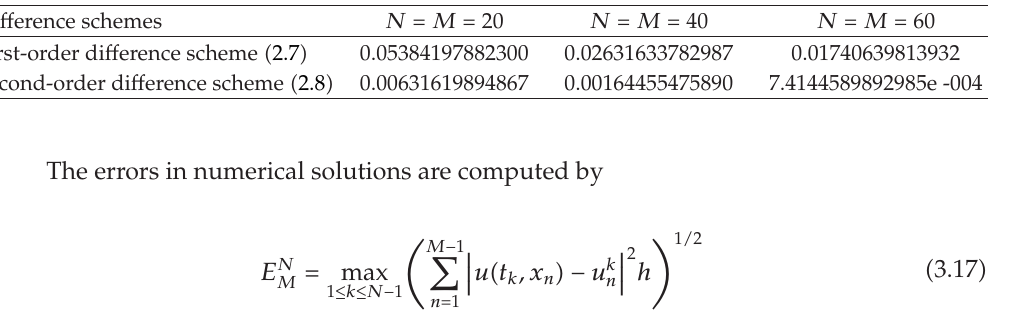
Table 1: Comparison of the errors of di ff erence